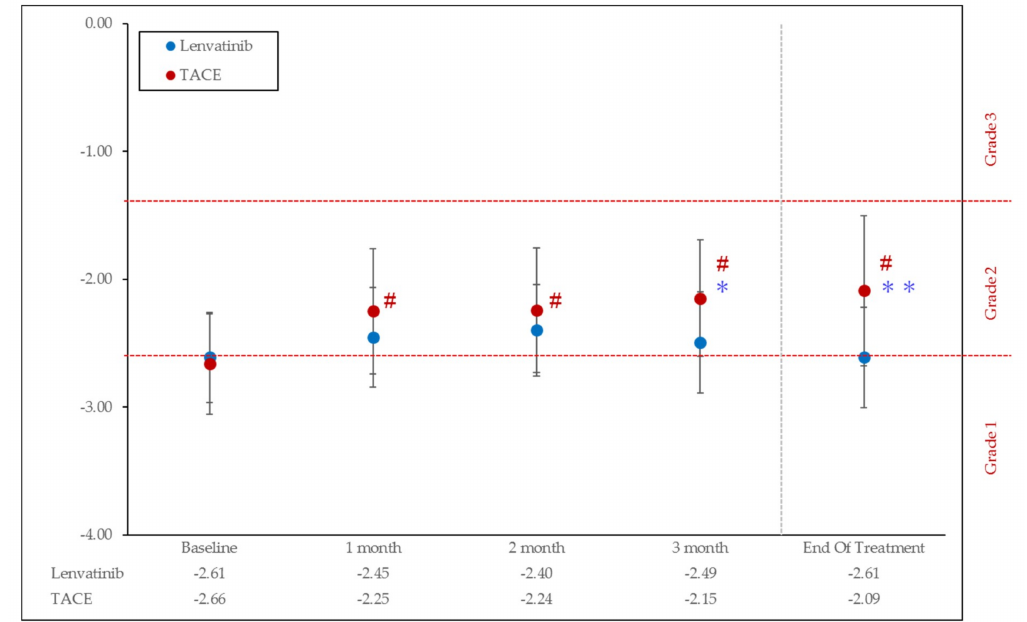
Figure 2. Albumin-bilirubin (ALBI) score over time in lenvatinib and TACE treated groups. ALBI score was significantly worsened at the end of treatment ( − 2.09) as compared with that at the baseline ( − 2.66) in the TACE treated group ( p < 0.01). In contrast, ALBI score was maintained at the baseline ( − 2.61) and at the end of treatment ( − 2.61) in the lenvatinib-treated group.